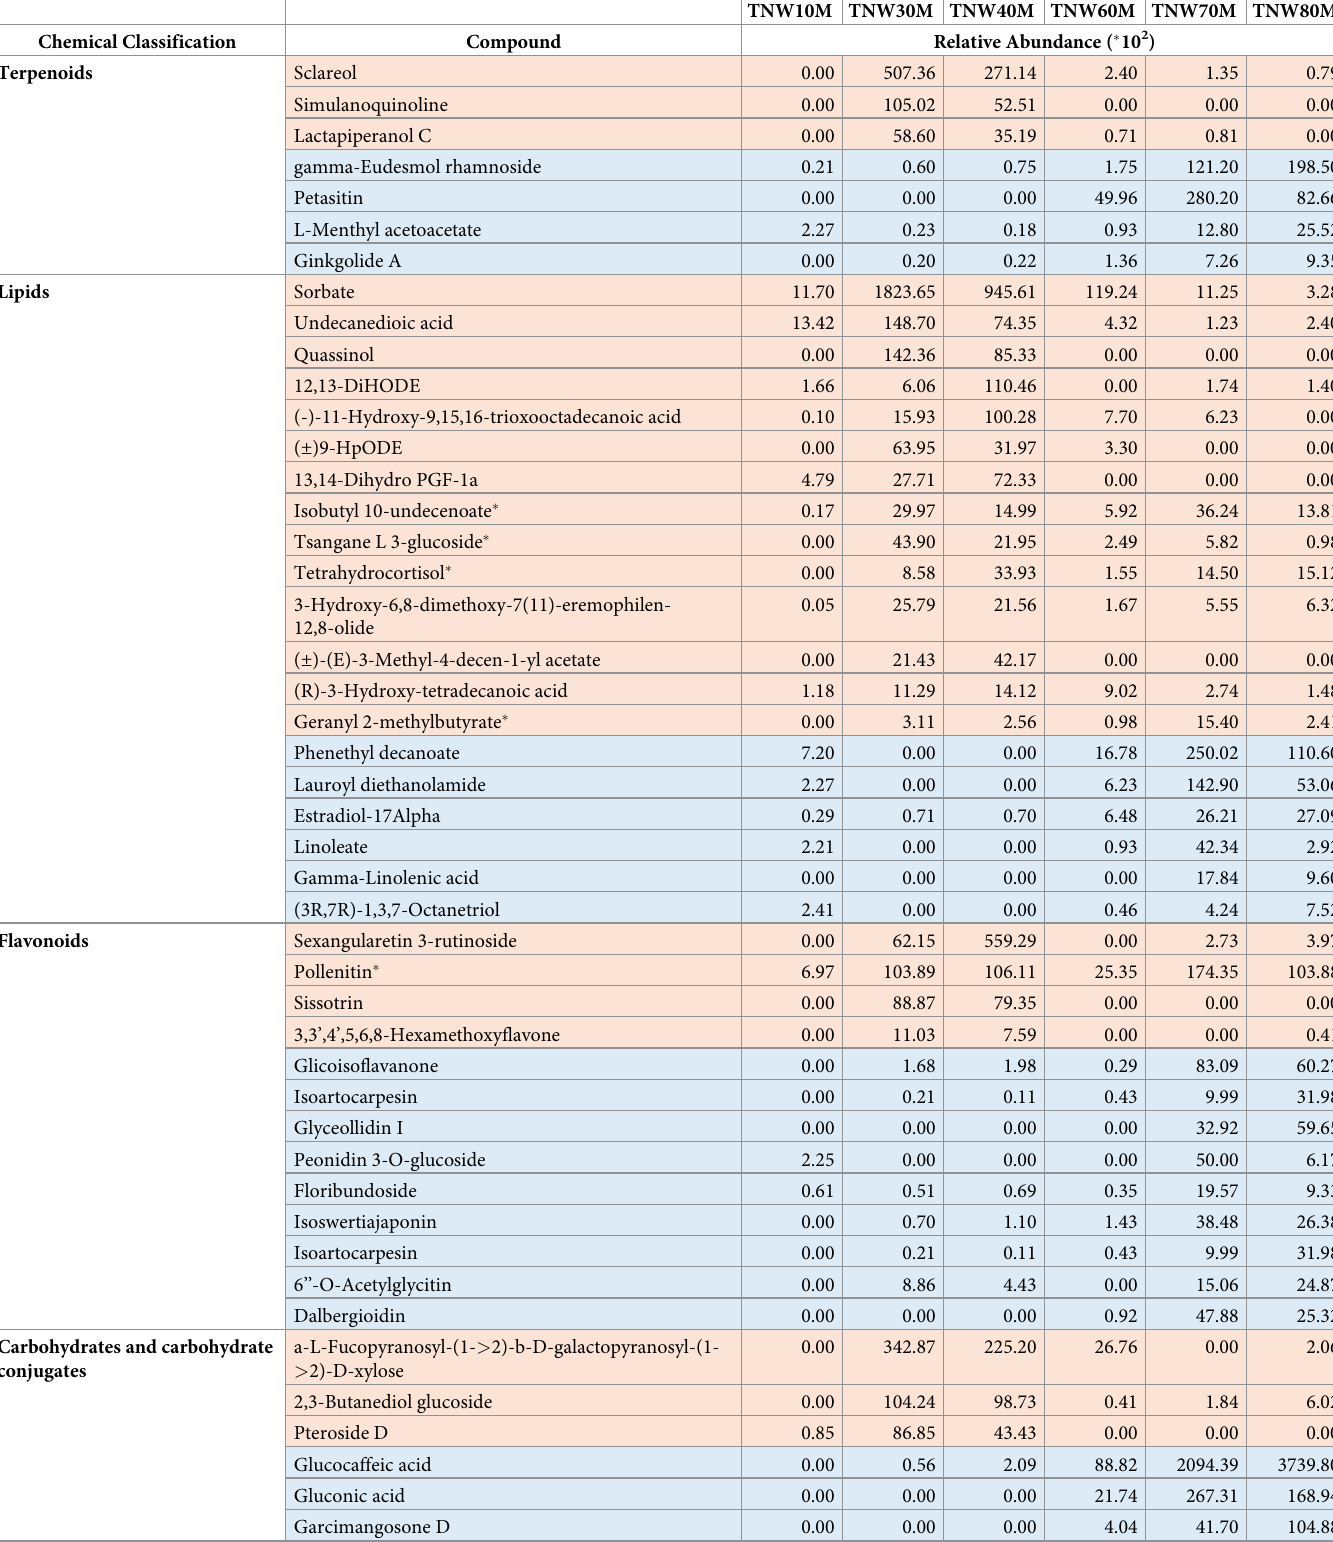
Table 4. Compounds with significantly higher abundance in TNW30M/TNW40M and TNW70M/TNW80M compared to TNW10M/TNW60M